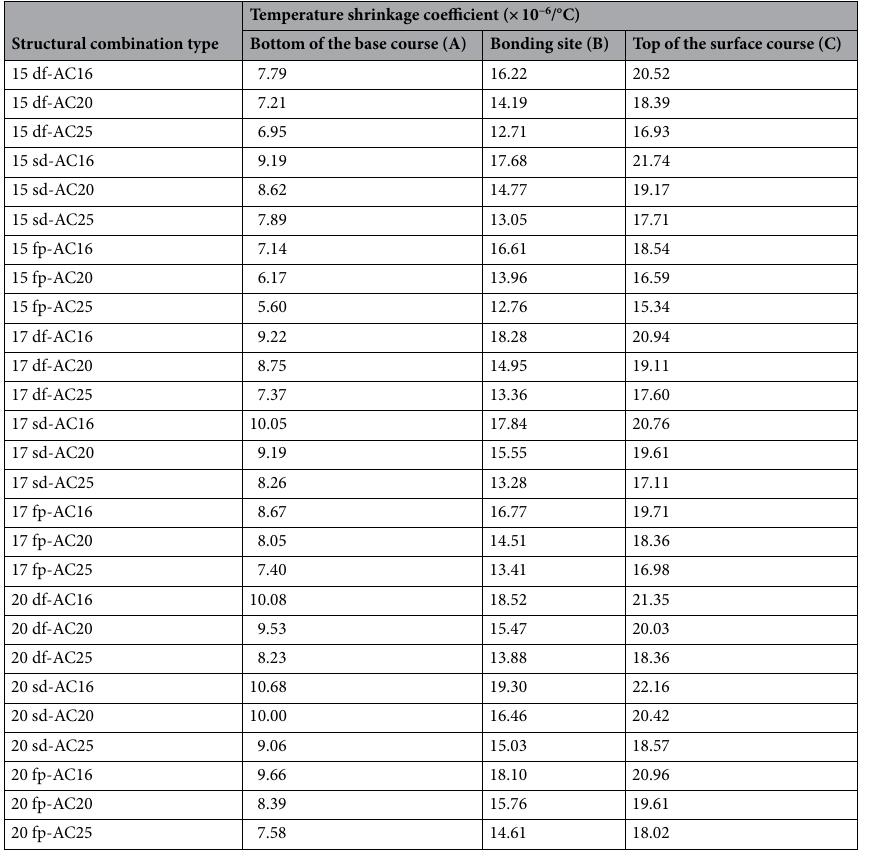
Table 2. Shrinkage coefficients of the semi-rigid base asphalt pavement composite